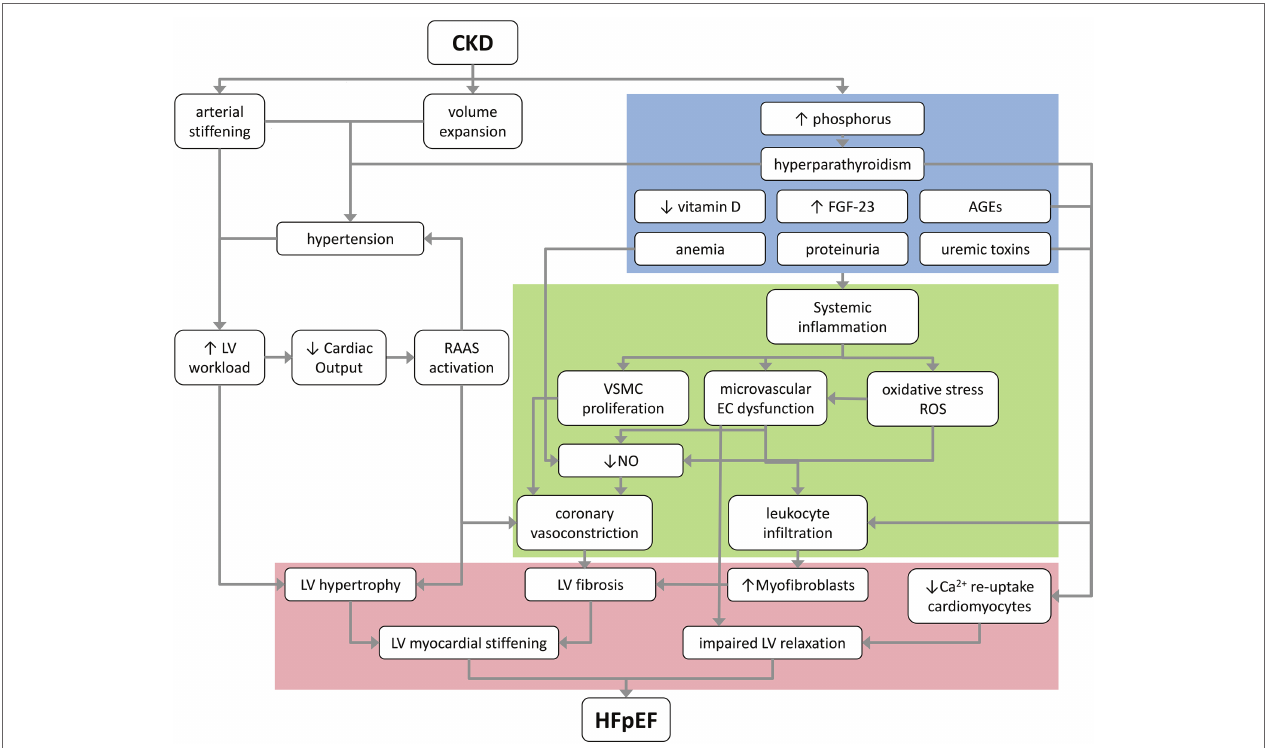
FIGURE 2 | A proposed schematic overview of the pathological mechanisms that underlie the progression of CKD to HFpEF. Blue box depicts renal factors; green box depicts coronary microvascular factors; and red box depicts myocardial changes contributing to HFpEF. AGEs, advanced glycation products; CKD, chronic kidney disease; EC, endothelial cell; FGF-23, fibroblast growth factor 23; HFpEF, heart failure with preserved ejection fraction; LV, left ventricle; NO, nitric oxide; RAAS, renin-angiotensin-aldosterone system; ROS, reactive oxygen species; VSMC, vascular smooth muscle